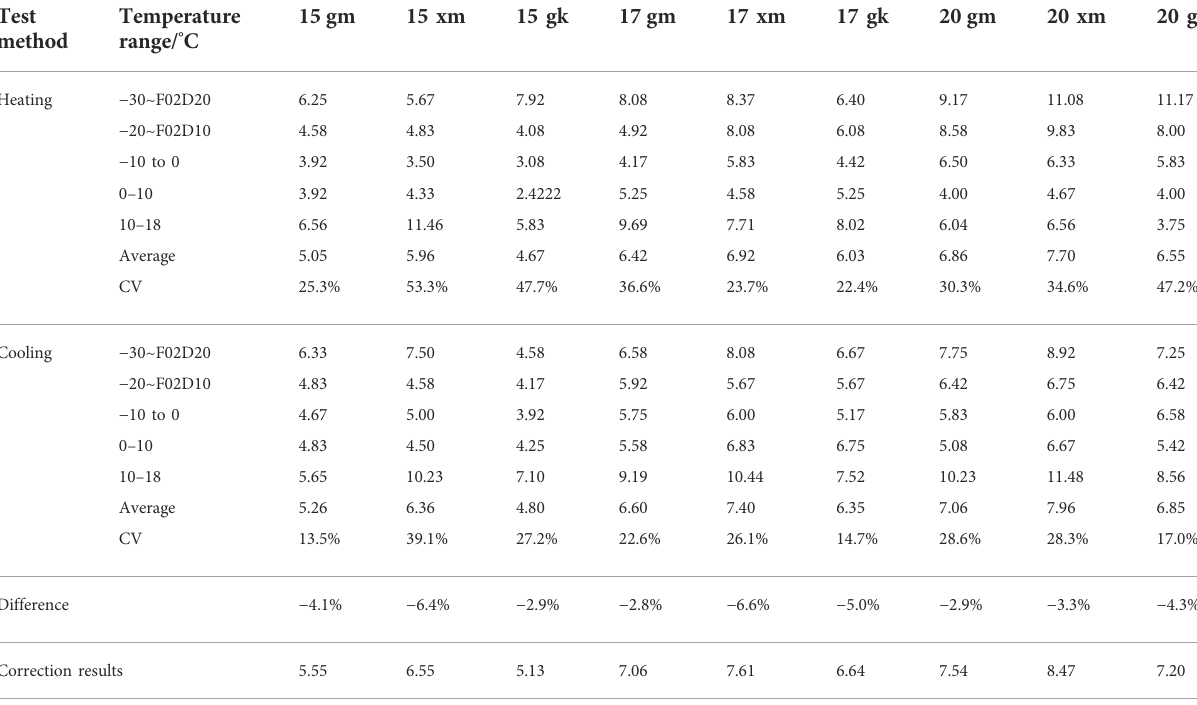
TABLE 2 Temperature shrinkage coef fi cient of the lime – fl y ash-stabilized macadam in different temperature ranges.